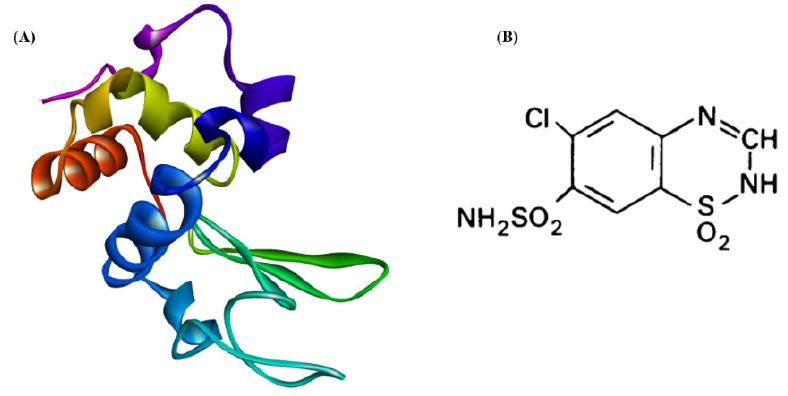
Figure 1. ( A ) Folded structure of HEWL. ( B ) Chemical structure of CTZ [23] .